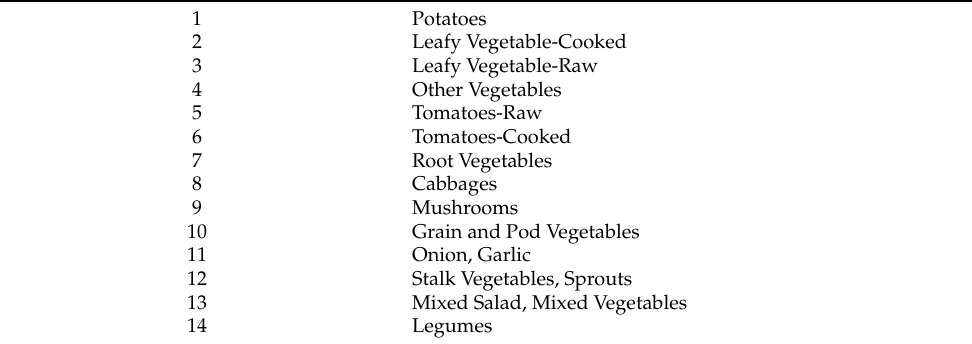
Table A1. Food items included in the EPIC FFQ were categorized in the following food categories for comparison with the 3-day food